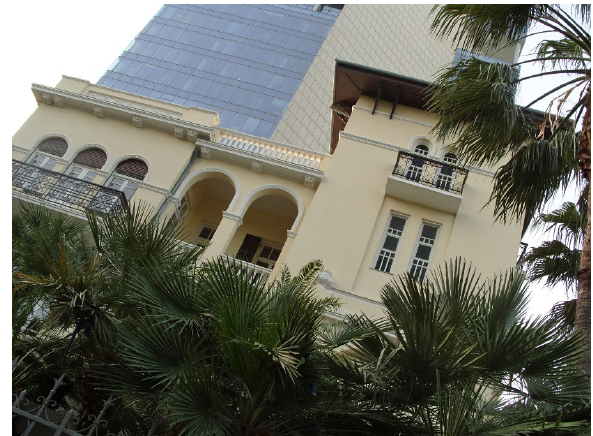
Figure 3. Example of an Eclectic Style building in the